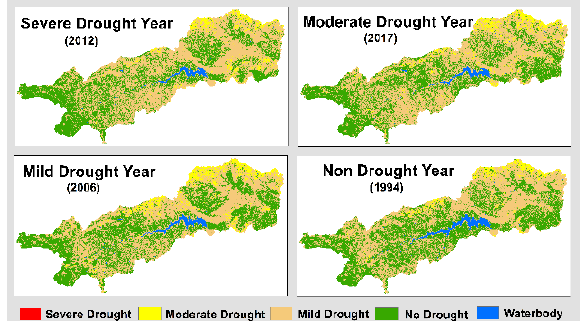
Figure 6. Drought intensity classes and non-drought